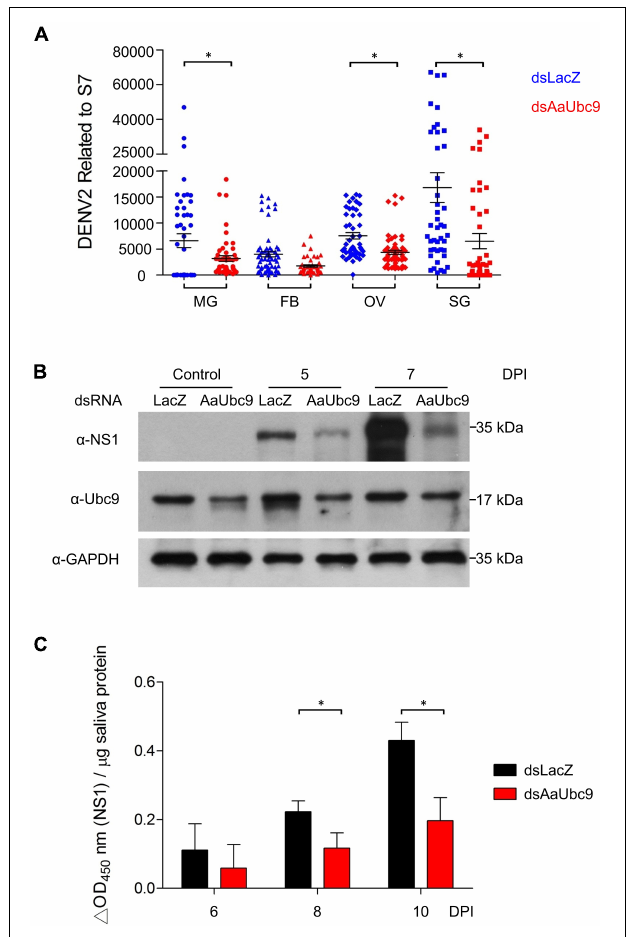
FIGURE 1 | AaUbc9 is essential for dengue virus replication and infectivity. (A) Three-day-old female mosquitoes were injected with dsRNA of LacZ (dsLacZ) or AaUbc9 (dsUbc9) 3 days prior to DENV2 infectious blood feeding (10 7 pfu/ml). Ten days post blood feeding, the midgut, body fat, ovary, and salivary gland were dissected, and total RNA was collected. The DENV2 genome transcription level was quantified using real-time PCR. The reactions were normalized to the ribosomal protein gene s7 . Comparisons were performed using the Tukey’s multiple comparison test with dsLacZ injection group; ∗ p ≤ 0.05. (B) Three-day-old female mosquitoes were injected with dsLacZ or dsAaUbc9. Three days post dsRNA injection the mosquitoes were infected with DENV2 through thoracic injection (200 pfu/mosquito). The protein levels of DENV2 NS1 were determined in female mosquitoes at 0, 5, and 7 days post viral injection by western blot with anti-NS1 antibody. GAPDH was used as an internal control. (C) Three-day-old female mosquitoes were injected with dsLacZ or dsAaUbc9 3 days prior to DENV2 infectious blood feeding (10 7 pfu/ml). The level of DENV NS1 protein was measured in mosquito saliva 6, 8, and 10 days post blood feeding using cell-based ELISA with an anti-NS1 antibody. Comparisons were performed using the Tukey’s multiple comparison test with dsLacZ injection group; ∗ p ≤